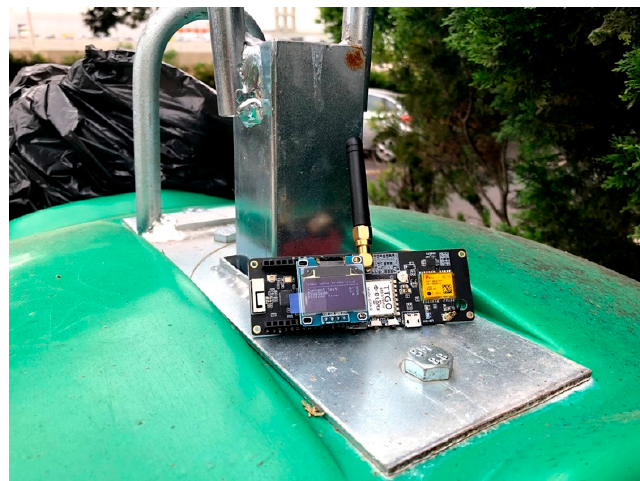
Figure 14. LoRa probe installed on top of an Iglô. Algorithm 1 Network Probe